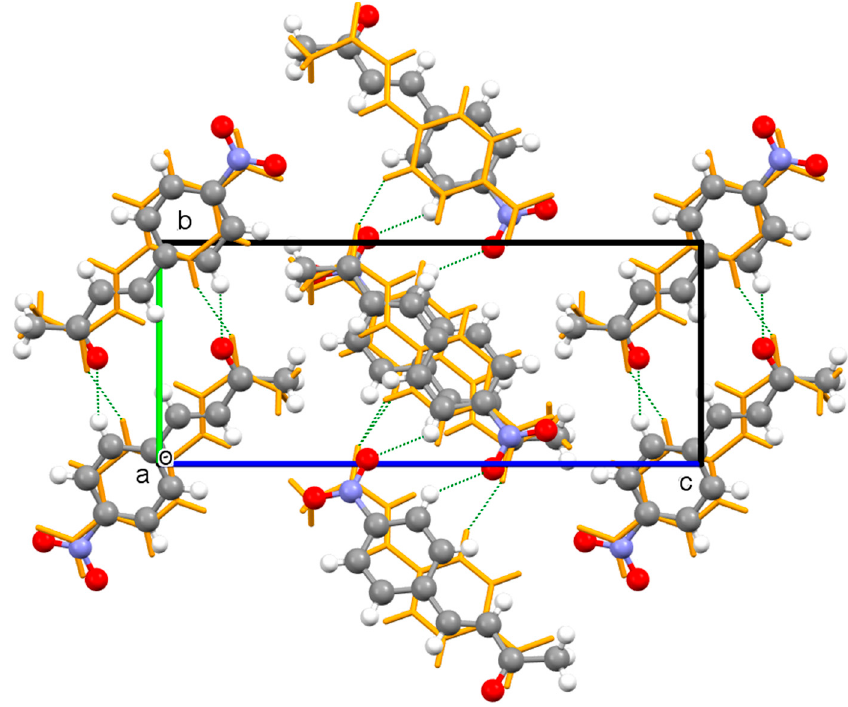
Figure 6. Crystal packing of compound II, minor component in orange and C–H ··· O contacts as dashed green lines.